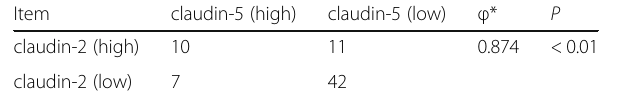
Table 3 Correlation between the expression of claudin-2 and claudin-5 in nasopharyngeal carcinoma tissues Item